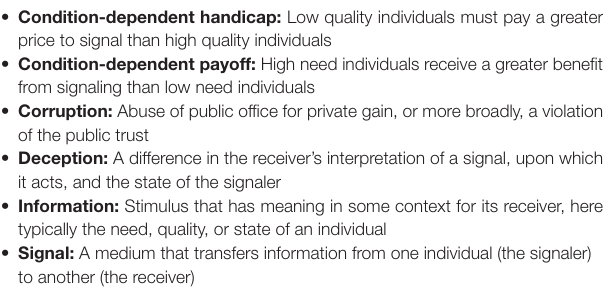
TABLE 1 | Glossary of key